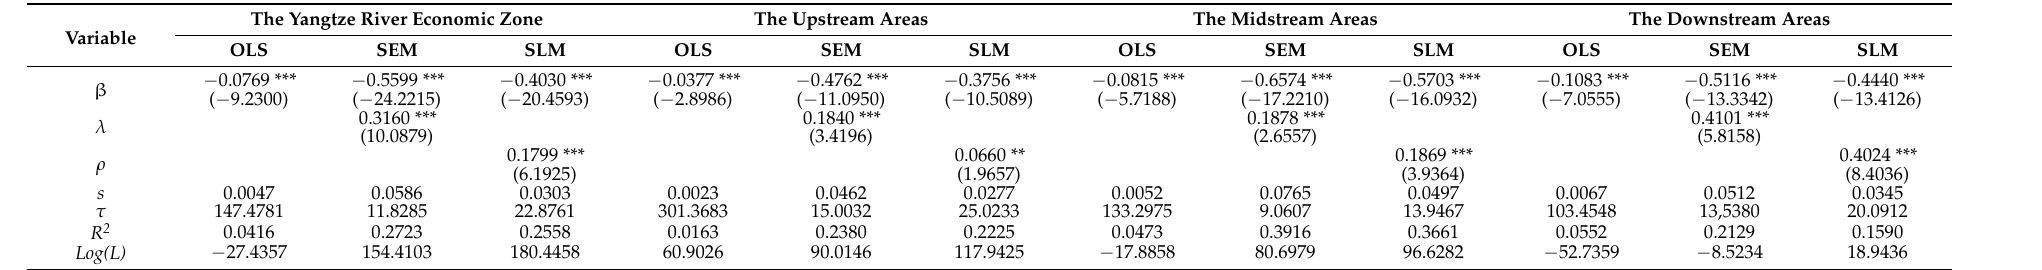
Table 3. Absolute β -convergence estimation result.